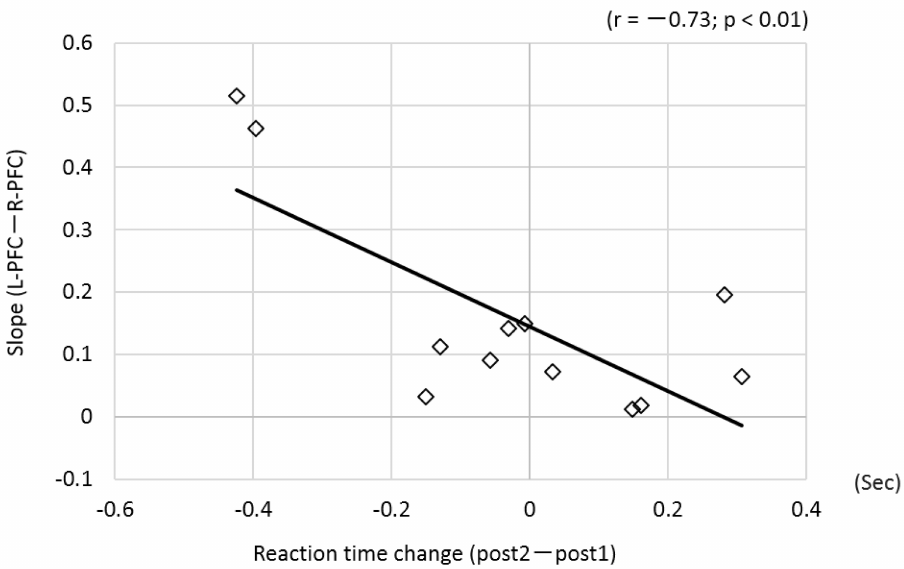
Figure 7. Correlation between the increase in the slope of O 2 Hb and the variation in reaction time. The horizontal axis represents the reaction time, and the vertical axis represents the difference in the increase in the slope of O 2 Hb. O 2 Hb: oxygenated